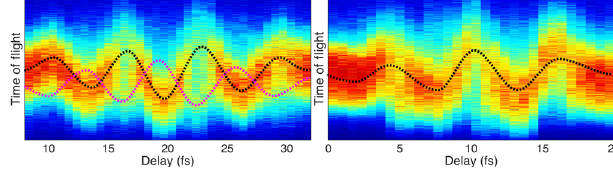
FIG. 5. Streaking traces performed using the same laser source, but a different HHG gas (argon), which offers higher flux at the expense of photon energy (centered 100 eV). The trace on the left for a randomly selected value of CEP clearly shows more than one attosecond pulse (highlighted with the dotted black and magenta curves). By selecting a value of CEP that results in a spectral continuum and maximum cutoff, the trace on the right is recorded, where only one attosecond pulse is detected. Argon gas is used primary for alignment, as the photon yield is higher and traces are acquired quicker; i.e., the full traces are acquired in 5 and 20 min,